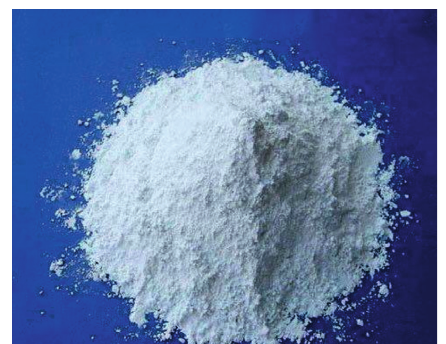
Figure 2: Quartz powder.